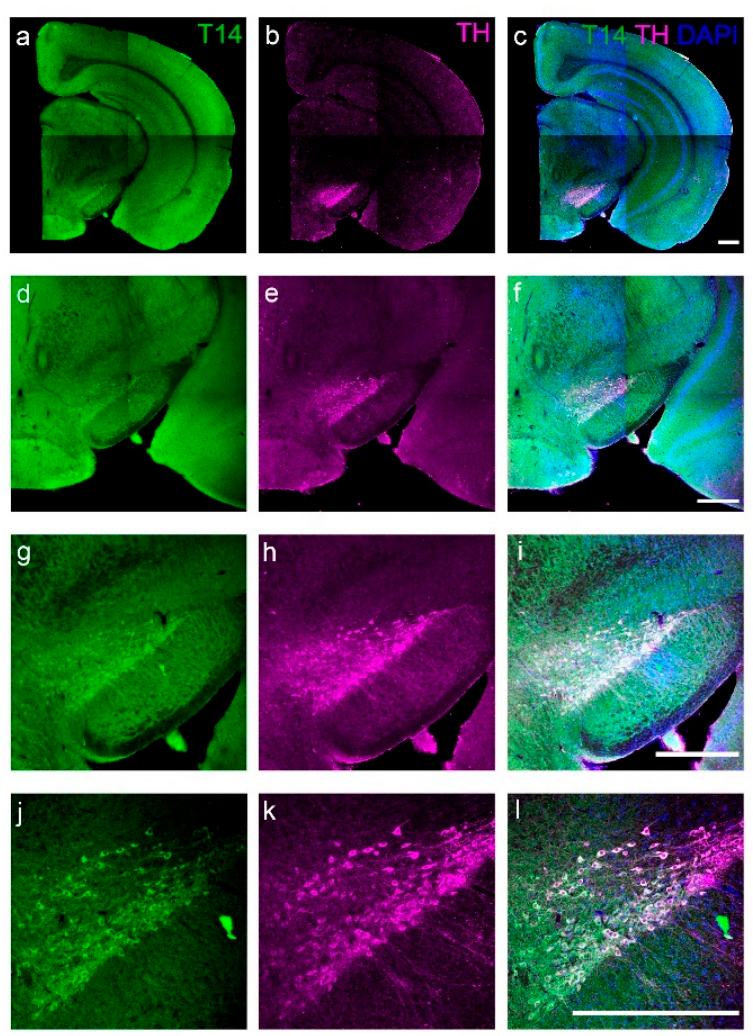
Figure 1. Photomicrographs of a representative coronal section of a mouse brain on postnatal day 21 at the rostro-caudal level of the substantia nigra showing immunofluorescence for T14 (appears green in ( a , d , g , j )) and tyrosine hydroxylase (appears magenta in ( b , e , h , k )), the primary enzyme in dopamine biosynthesis. Images at increasing magnification ( c , f , I , l ) demonstrate the co-localization of these factors within the cell bodies of the pars compacta of the substantia nigra. Cell nuclei are shown by DAPI fluorescence (blue). Scale bars: 500 µm.